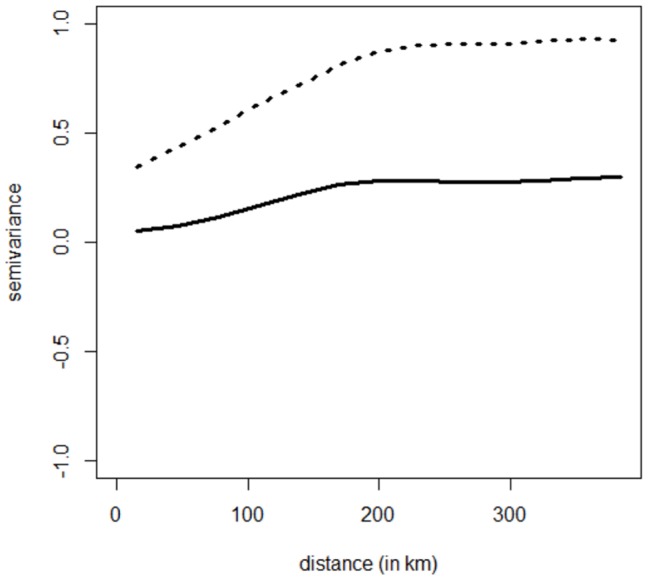
Semi-variogram of the OLS model (dashed line) and the SARerr model (solid line).